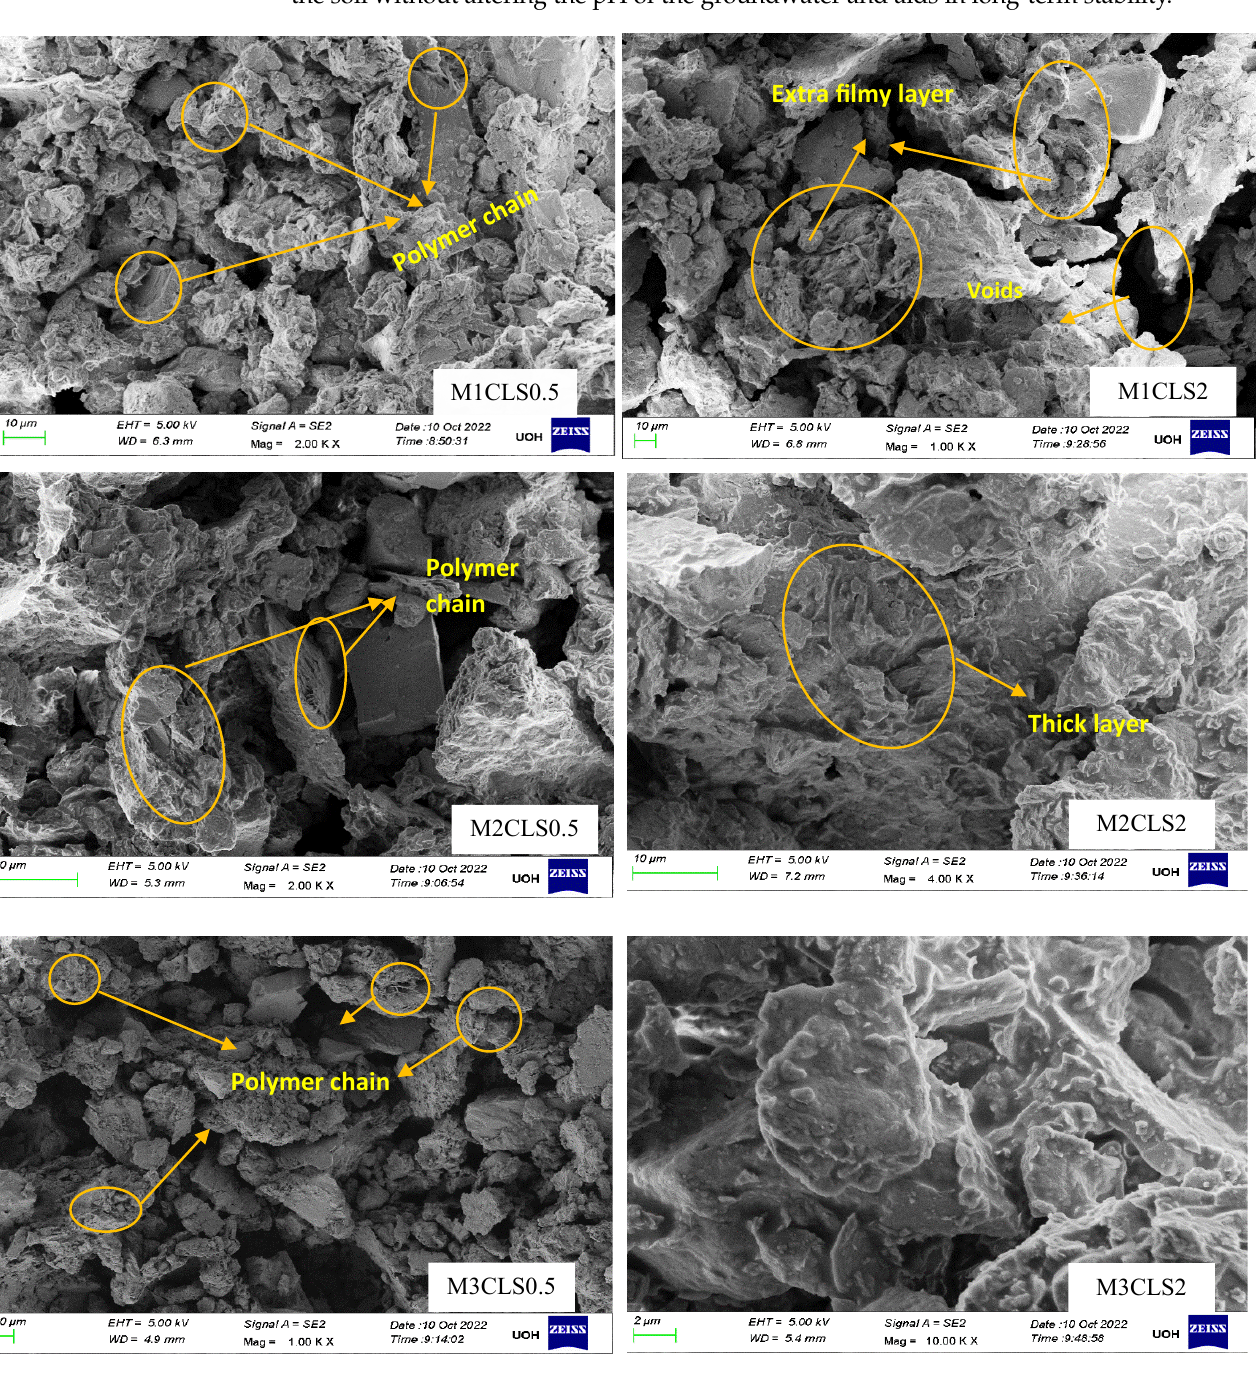
Figure 9. SEM images of binary blended clay after 28 days of